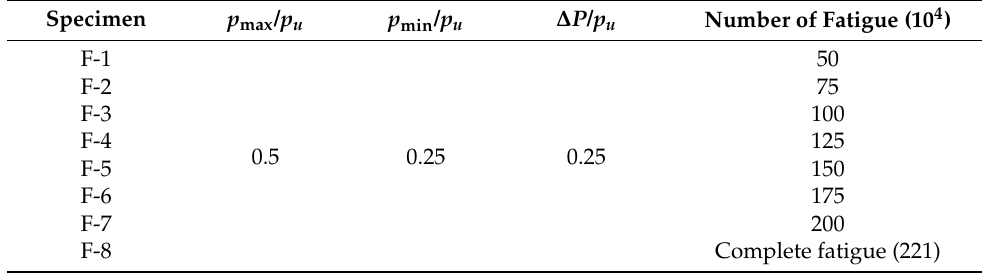
Table 3. Fatigue loading test